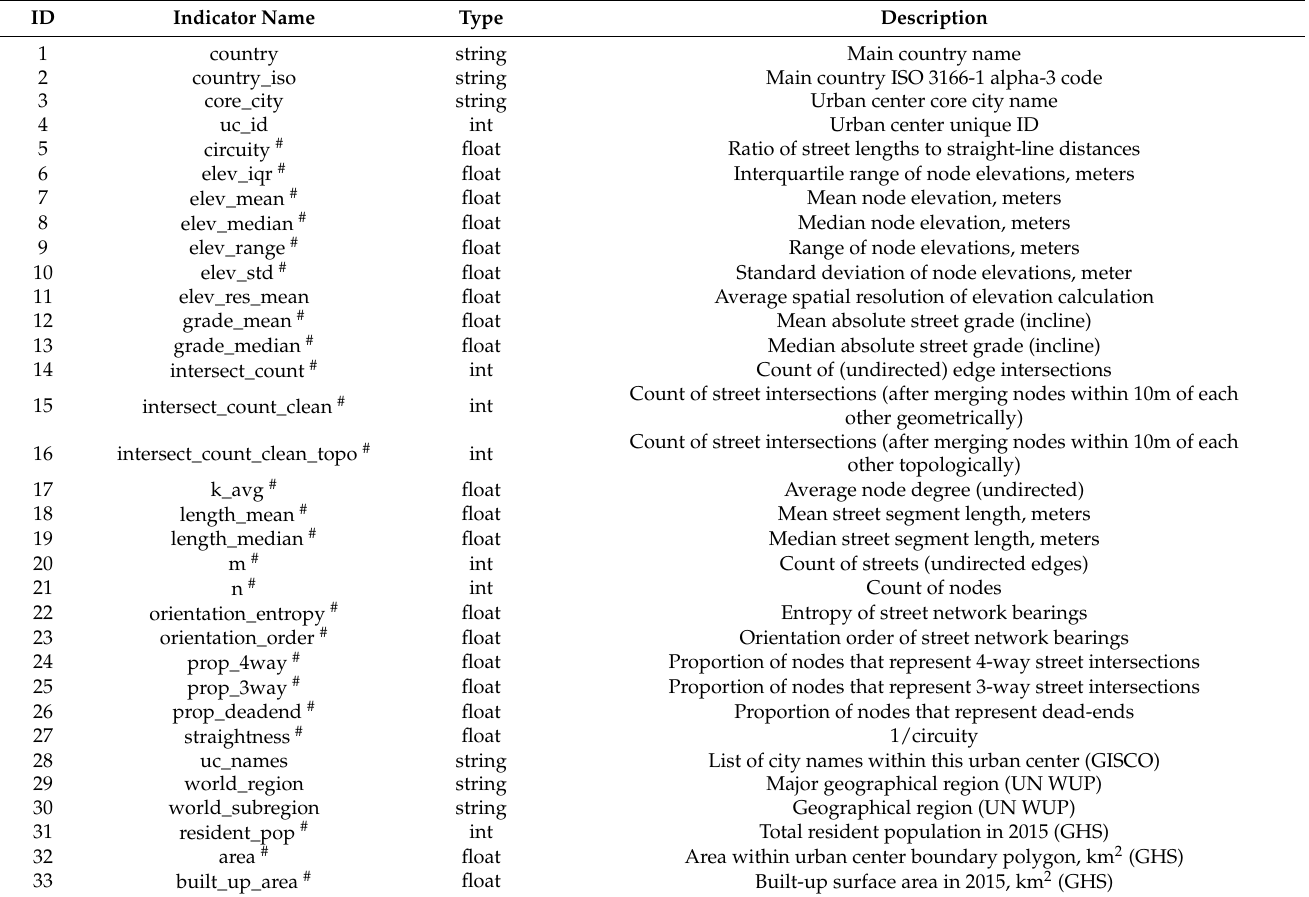
Table 2. Thirty-three indicators in the global urban street network data